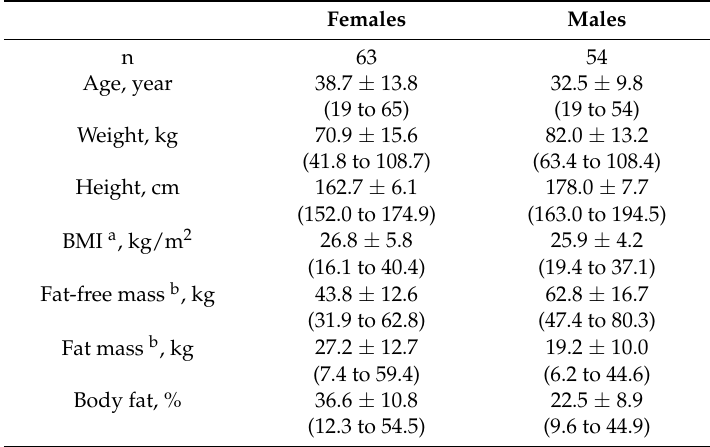
Table 1. Physical characteristics of 117 study participants. Values are mean ± SD (range of values).